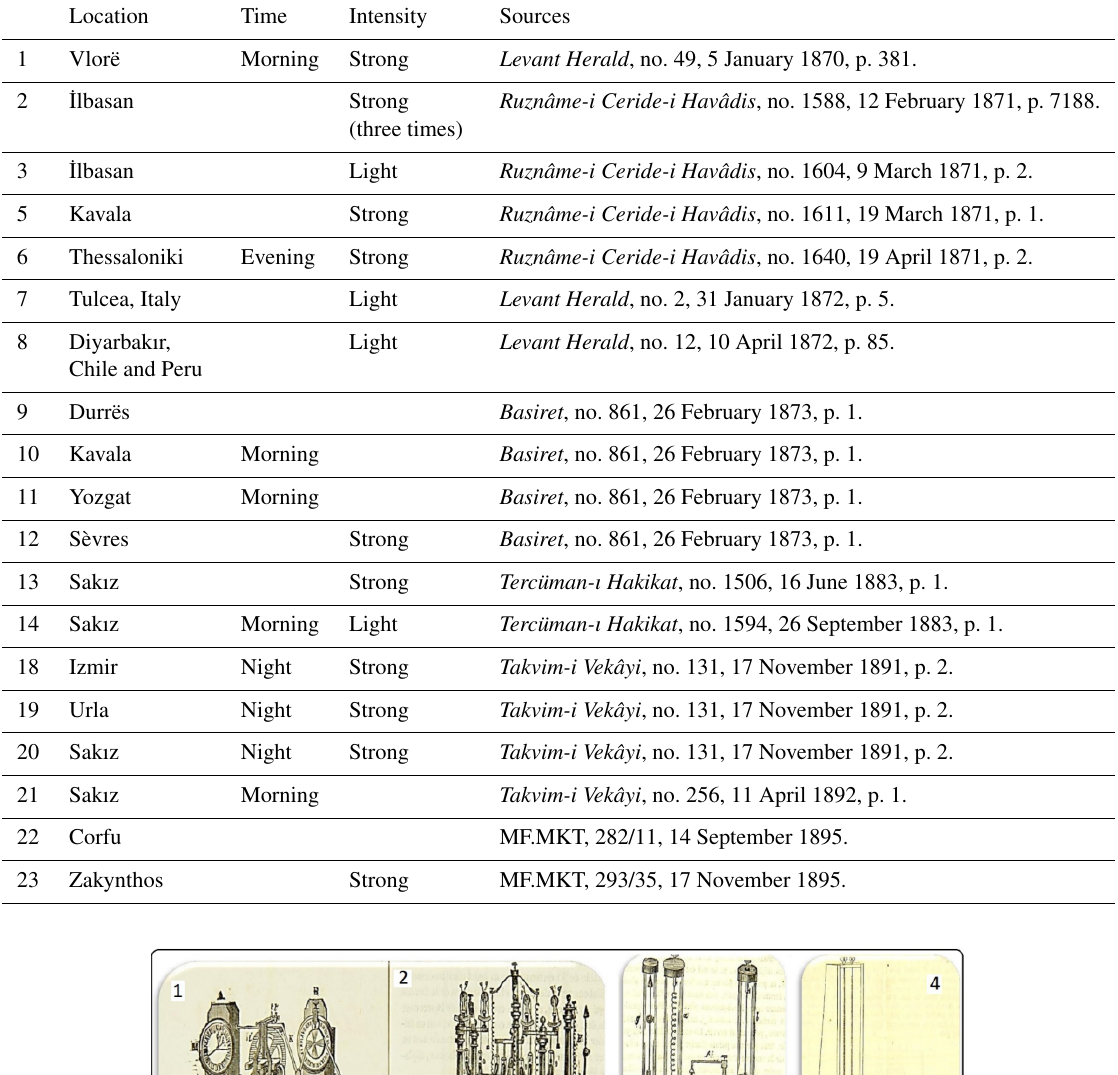
Table 2. Some earthquake information (between 1870 and 1895) to be sent to the Rasathane-i Amire (Fettahoglu, 2002). Location